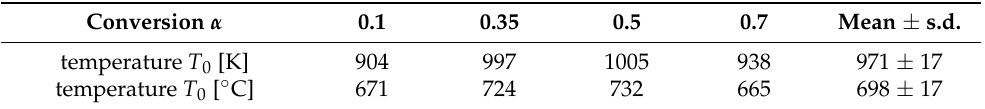
Figure 7. Arrhenius plot for austenitization of SA 508 Gr.3 steel using isoconversional method [2] (reduced data) based on the modified Arrhenius equation in the form of Equation (27), with com- mon regression parameter T 0 for all α values.